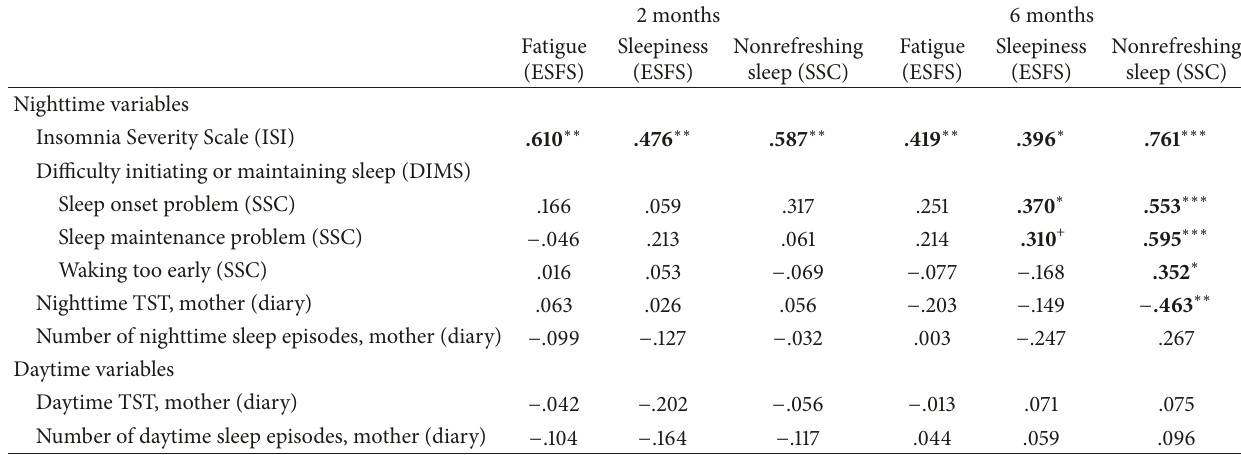
Table 4: Correlations of daytime variables with mothers’ sleep characteristics.